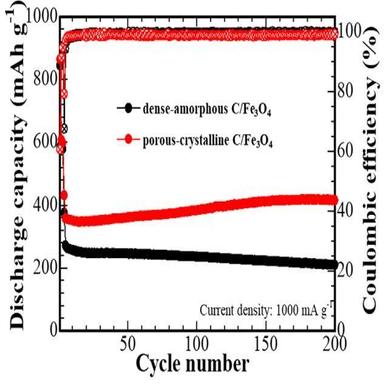
Long-term cycle performance of the dense-amorphous (a) and porouscrystalline (b) C/Fe3O4 microspheres cycled in the potential window of 0.01–3 V at a current density of 1000 mA g1 .